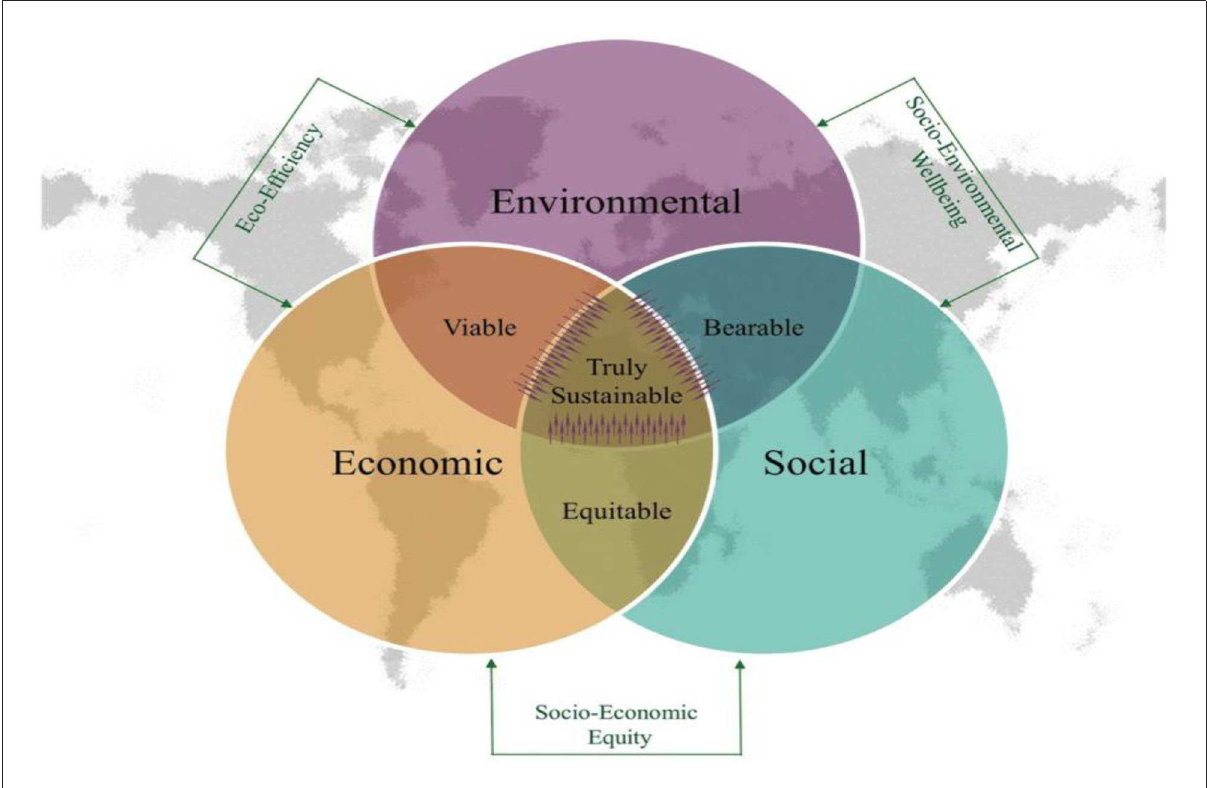
FIGURE2 Triple bottom line concept (Tasdemir et al.,